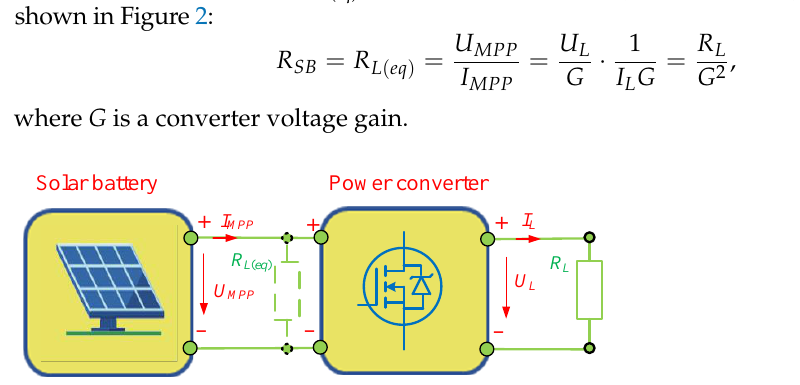
Figure 2. Equivalent load resistance R L ( eq ) tuning with a power converter.